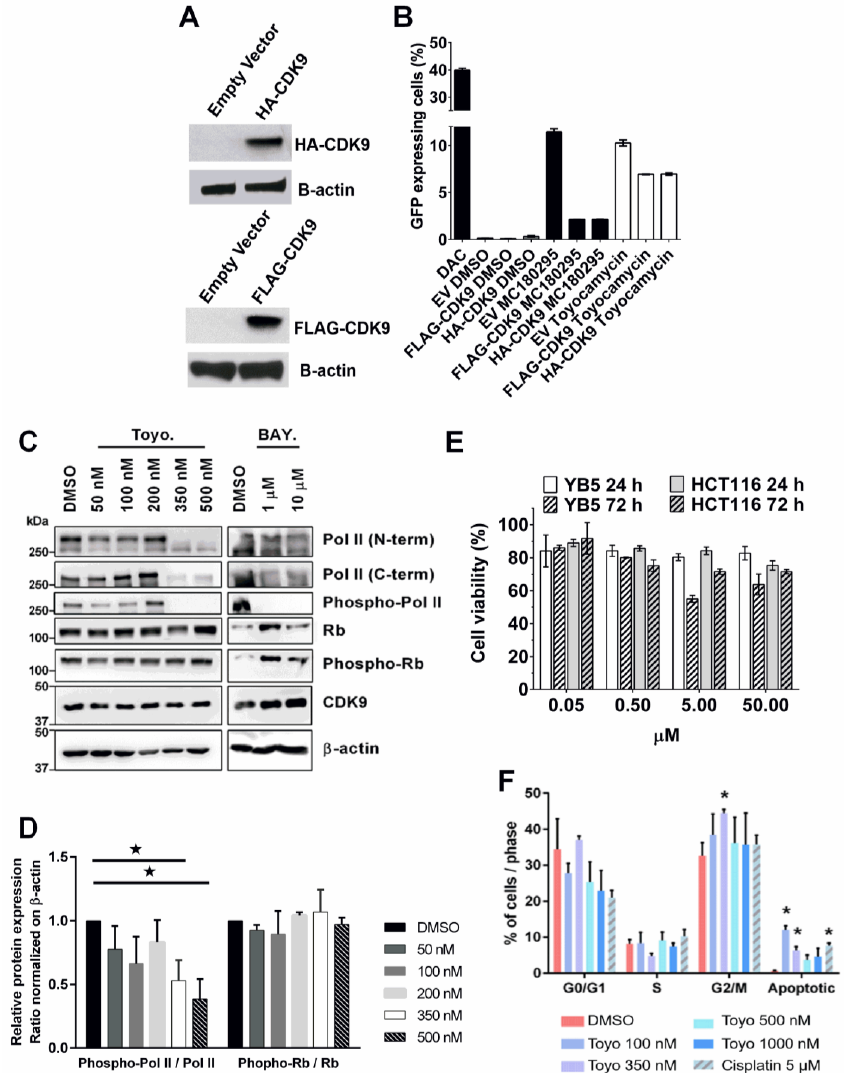
Figure 4. Toyocamycin demonstrates CDK9 inhibition in colon cancer cells. YB5 cells were transfected with HA-CDK9 or FLAG-CDK9 vectors. ( A ) Western blotting shows transfection efficiency. Loading control is shown using β -actin antibody. ( B ) Percentage of GFP-expressing YB5 cells after DNA hypomethylating drug (DAC, 50 nM, 72 h) or selective CDK9 inhibitor (MC180295, 500 nM, 48 h) in presence or absence of CDK9-expressing vectors ( n = 2). ( C ) Protein expression levels of CDK9 and cell cycle CDK targets. RNA-Pol II (N-term and C-term), phospho-Pol II, Rb, phospho-Rb, and CDK9 levels were measured after 6 h toyocamycin treatment in HCT116 cells (doses are indicated in the graph) or with DMSO. Treatments with CDK9 inhibitor BAY 1251152 at 1–10 µ M for 16 h were used as a positive control. β -actin was used as loading control. Molecular weight of each protein is indicated on the graph. Full western blots are available in supplementary. ( D ) Ratio of Phospho-Pol II Ser 2/Pol II and Phospho-Rb T826/Rb, normalized on β -actin and DMSO are shown (mean ± SEM, N ≥ 3 biological replicates, *: p ≤ 0.05 obtained by unpaired Student’s t test). ( E ) Cell viability analysis by Viacount staining in YB5 and HCT116 cells after 24 and 72 h toyocamycin treatment (0.05, 0.5, 5, and 50 µ M, n = 3) relative to untreated cells. ( F ). Cell cycle analysis by flow cytometry in HCT116 cells after 6 h toyocamycin treatment followed by 18 h without exposure ( n = 3, a star indicates statistical difference between treated group and control, unpaired Student’s t -test, p <